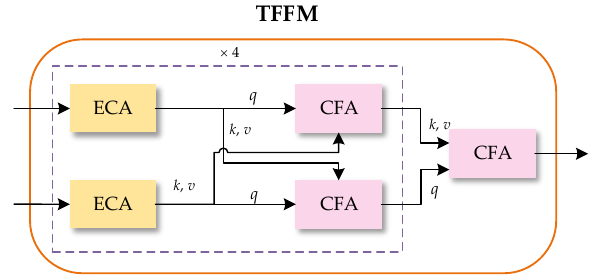
Figure 4. Structure of the Transformer Fusion Feature Module (TFFM). ECA represents the Ego- Context Augment module and CFA represents the Cross-Feature Augment module. As shown in the dotted box, two ECAs and two CFAs form a fusion layer. The fusion layer is repeated four times, and then a CFA is added to fuse the feature maps of the two